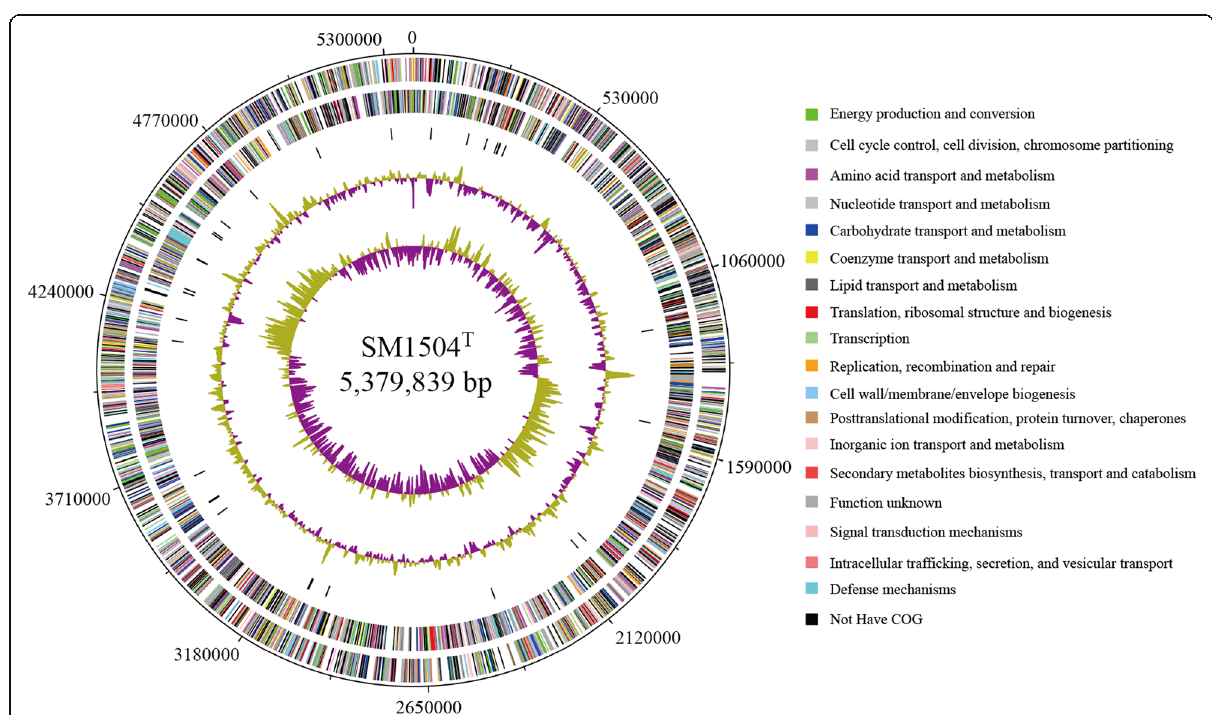
Fig. 3 Circular map of the Arcticibacterium luteifluviistationis SM1504 T genome. From the outside to the center: CDSs on forward strand (colored by COG categories), CDSs on reverse strand (colored by COG categories), RNA genes (tRNAs and rRNAs), G + C content and GC